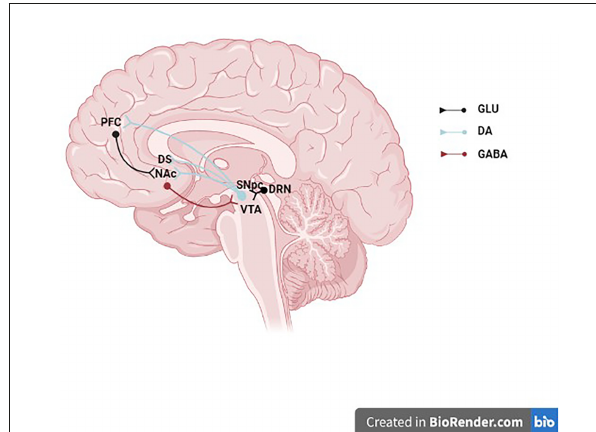
FIGURE1 Midbrain dopaminergic neurons. The schematic illustrates a midbrain dopaminergic neurons projecting to the NAc, DS, and PFC and receiving synaptic inputs from a GLU DRN neuron and a GABAergic NAc neuron. GLU, glutamate; DA, dopamine; GABA, γ - aminobutyric acid; PFC, prefrontal cortex; DS, dorsal striatum; NAc, nucleus accumbens; SNpc, substantia nigra pars compacta; VTA, ventral tegmental area; DRN, dorsal raphe nucleus.